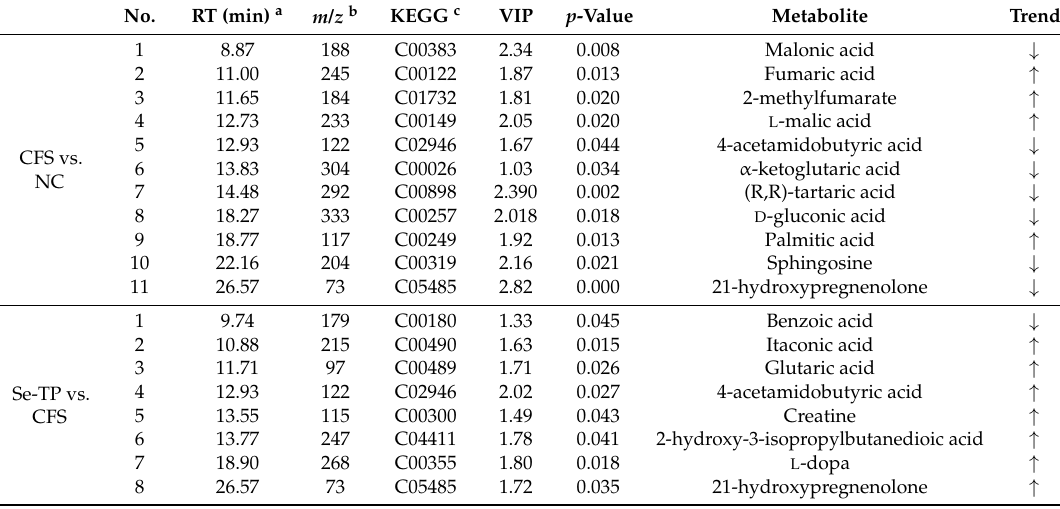
Table 3. Differential metabolites of CFS group vs. Se-TP